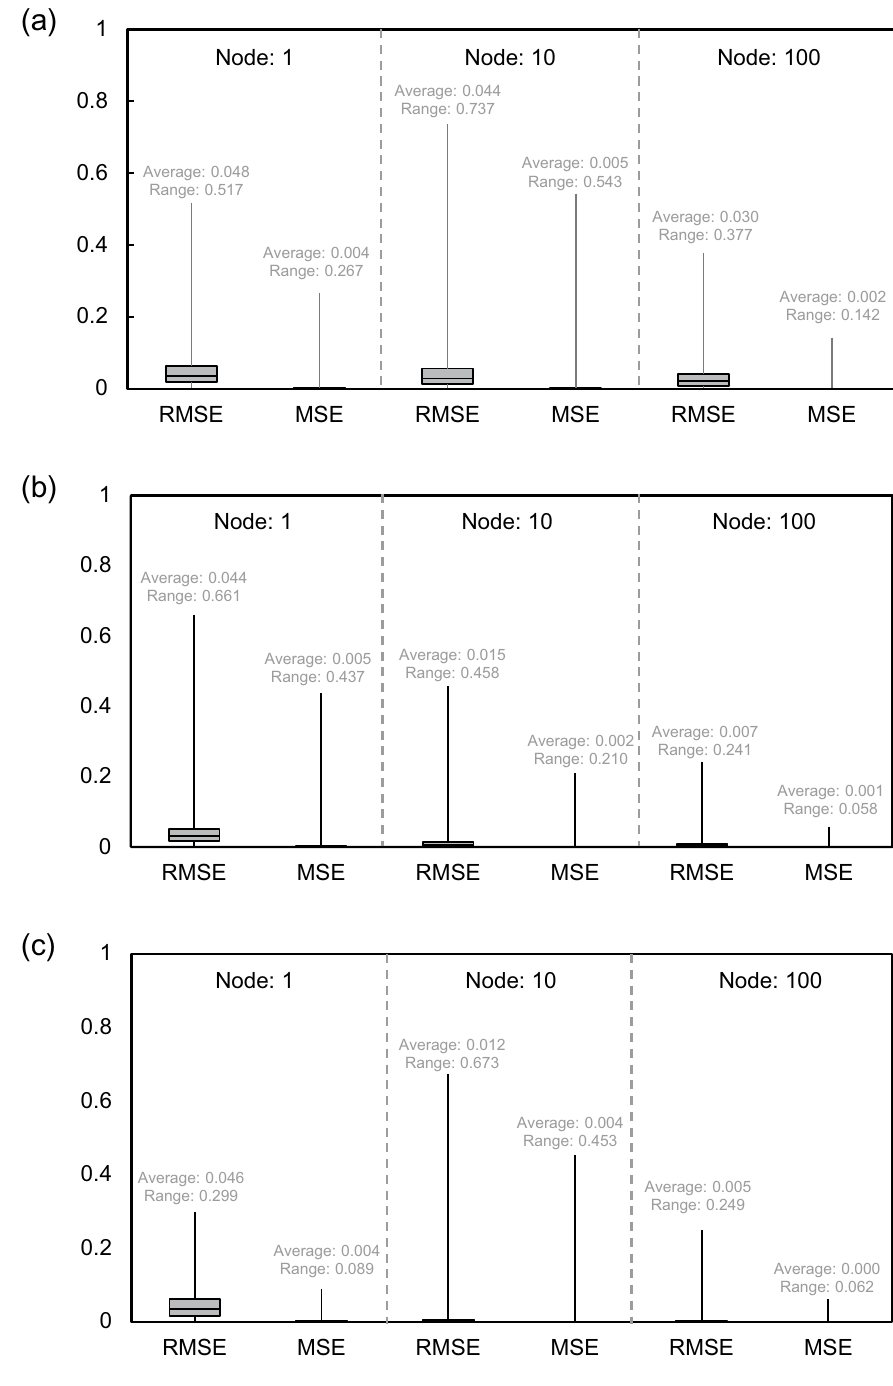
Figure 16. Distribution of RMSE and MSE based on neural network: ( a ) gradient descent; ( b ) Levenberg– Marquardt; ( c ) Bayesian